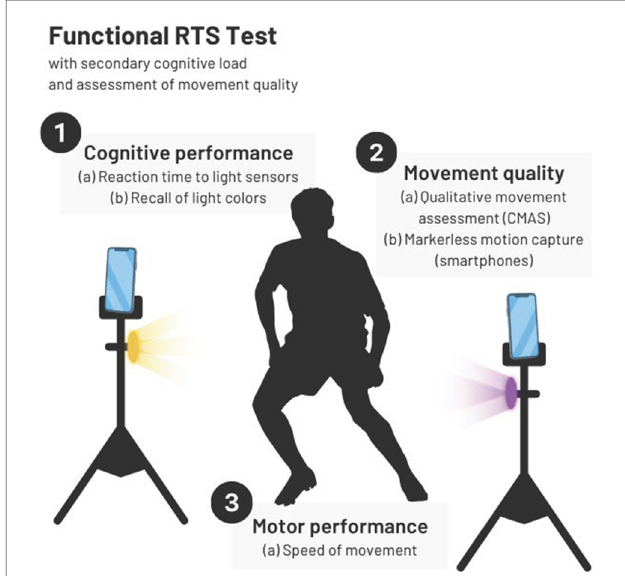
FIGURE 2 Proposed functional RTS test, including measures of cognitive performance, movement quality, and motor performance. CMAS, cutting movement assessment